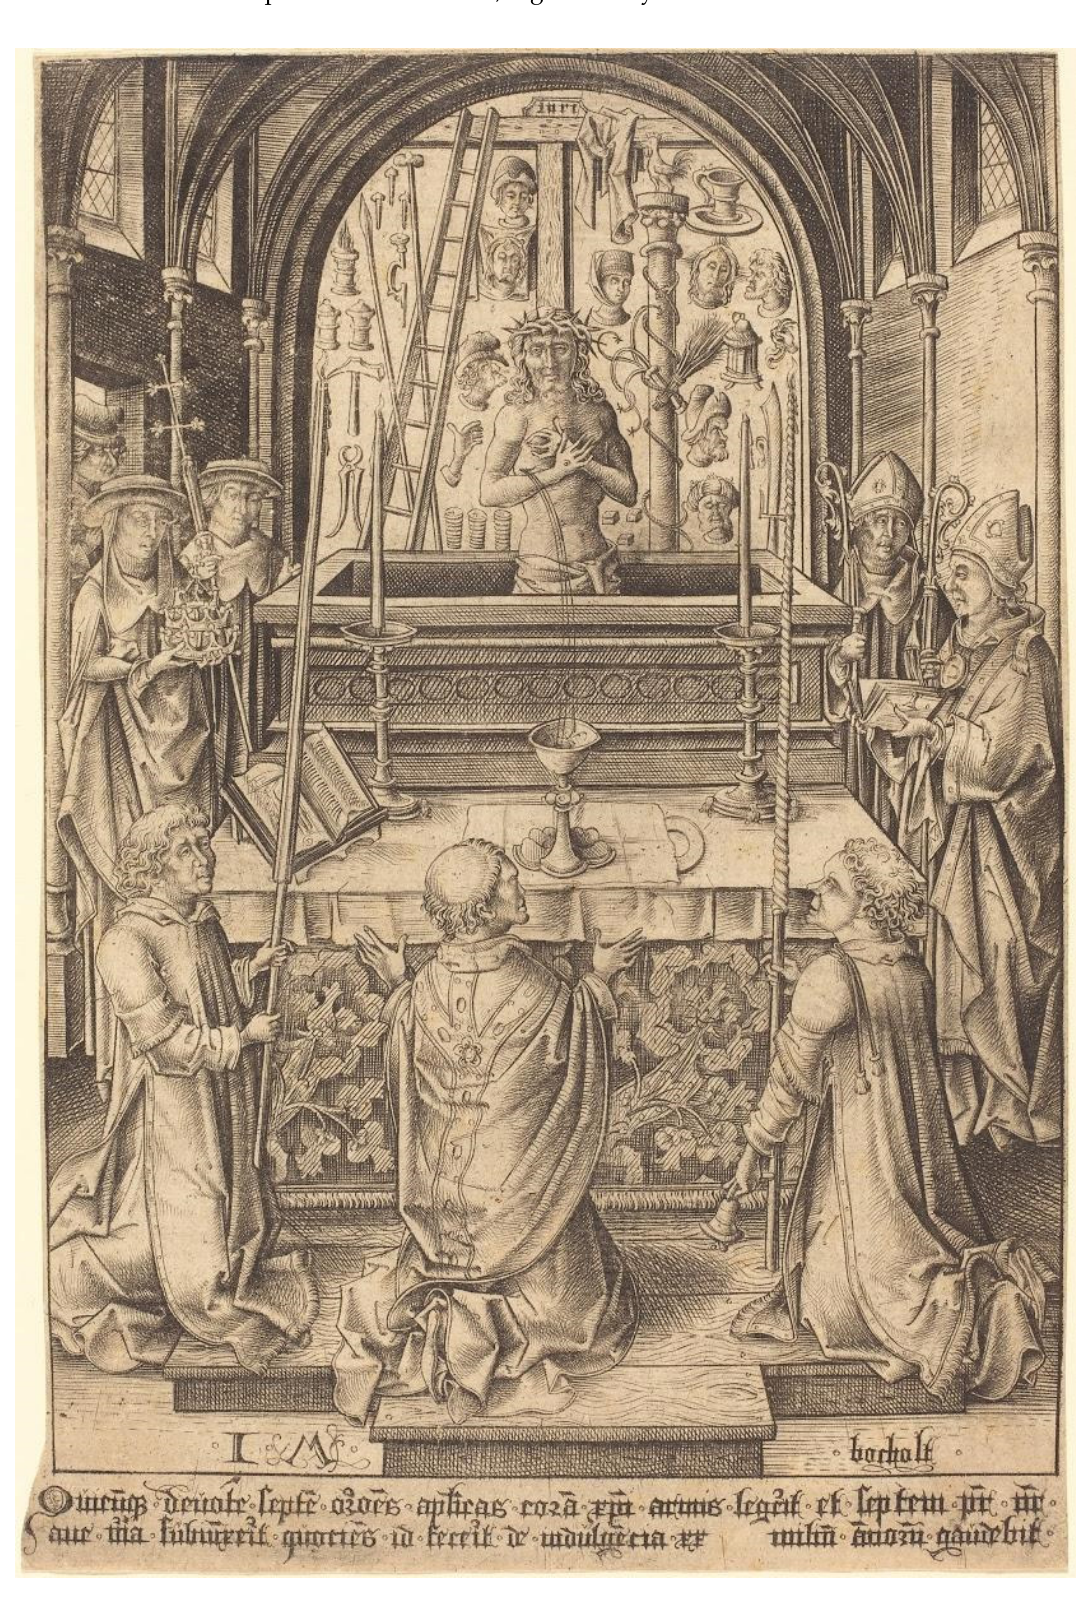
Figure 15. Israhel von Meckenem, Mass of St Gregory c.1480–1485, National Gallery of Art, Washington DC, Rosenwein Collection .